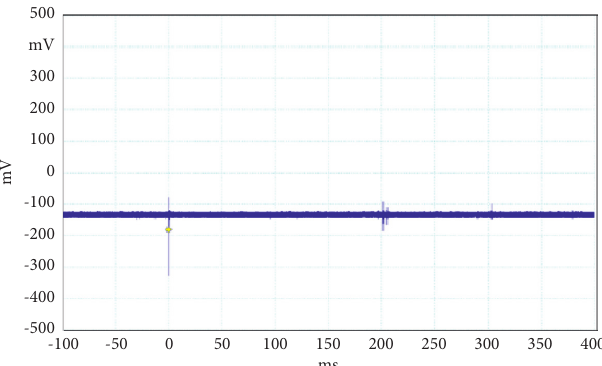
Figure 8: Example of the unusual lightning signal of window size 500ms, which is recorded as a flash number 20150611-0003 in Kathmandu,